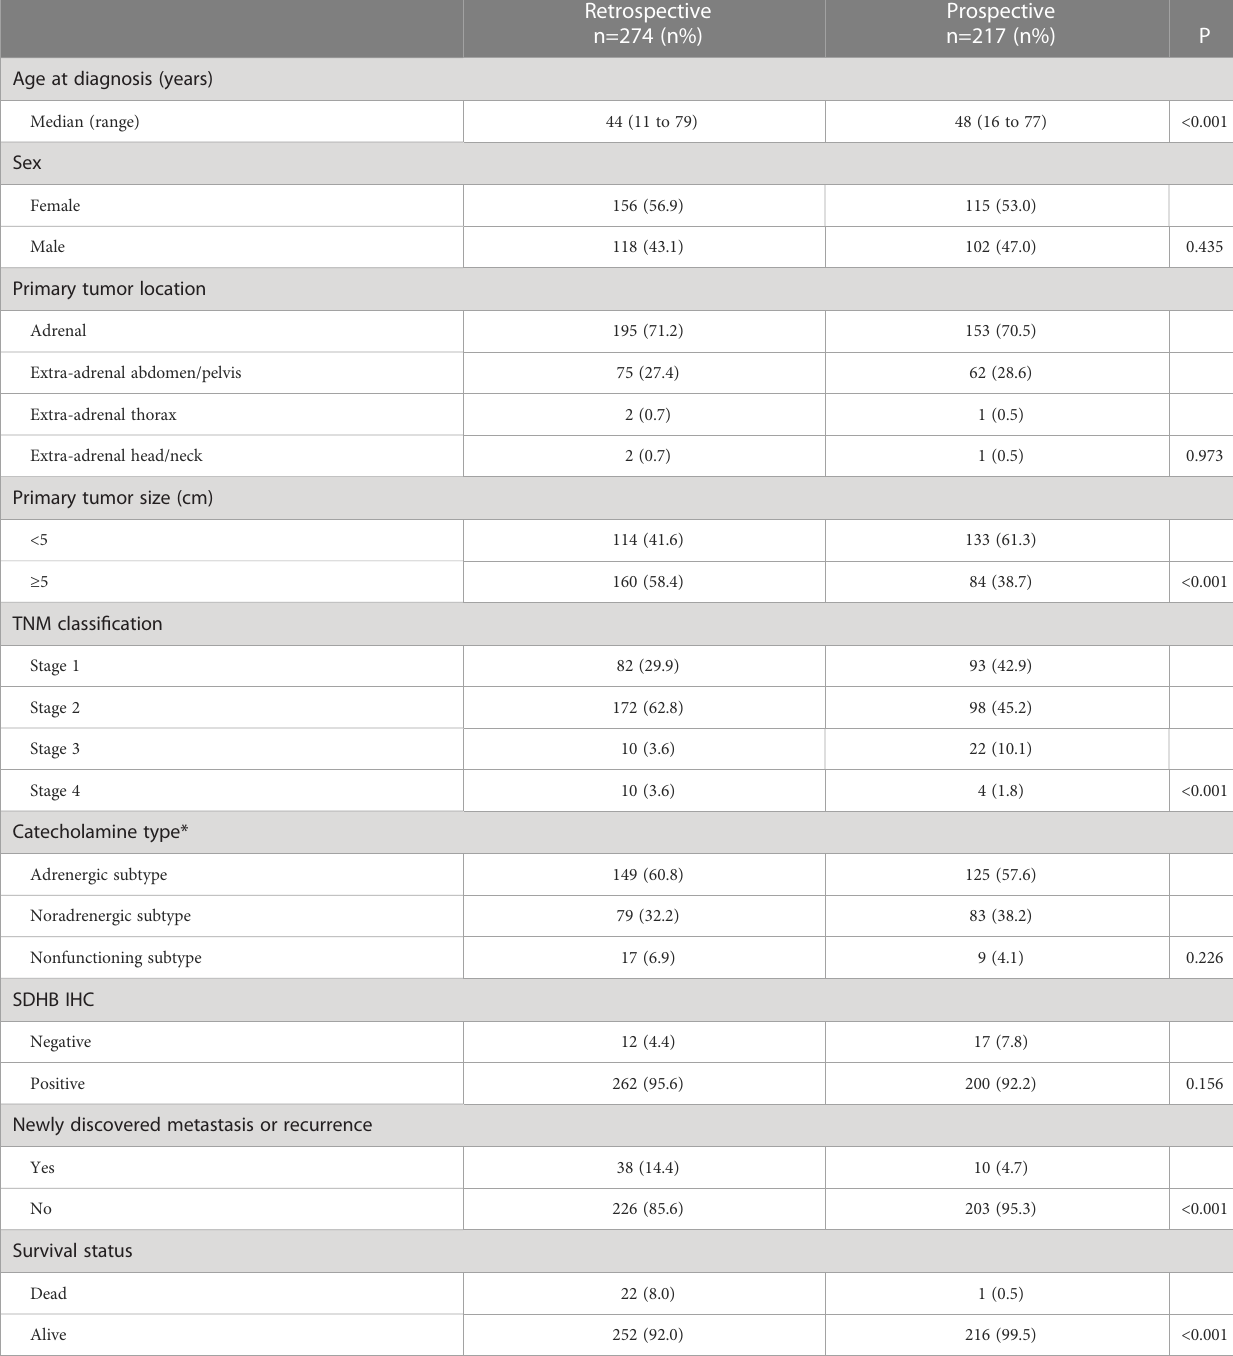
TABLE 1 Demographics and baseline characteristics of the study